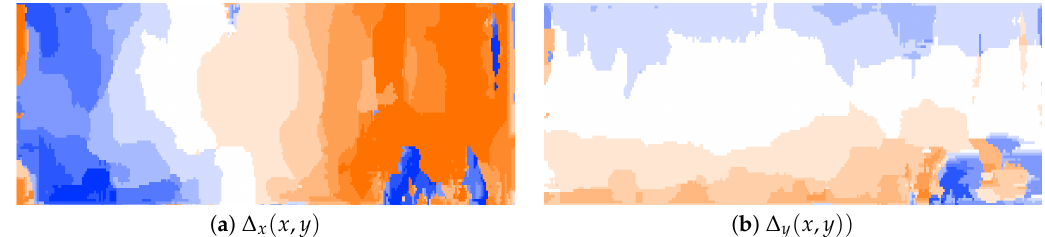
Figure 4. Optical flow example. Image codification as proposed in the Tsukuba benchmark dataset [36].